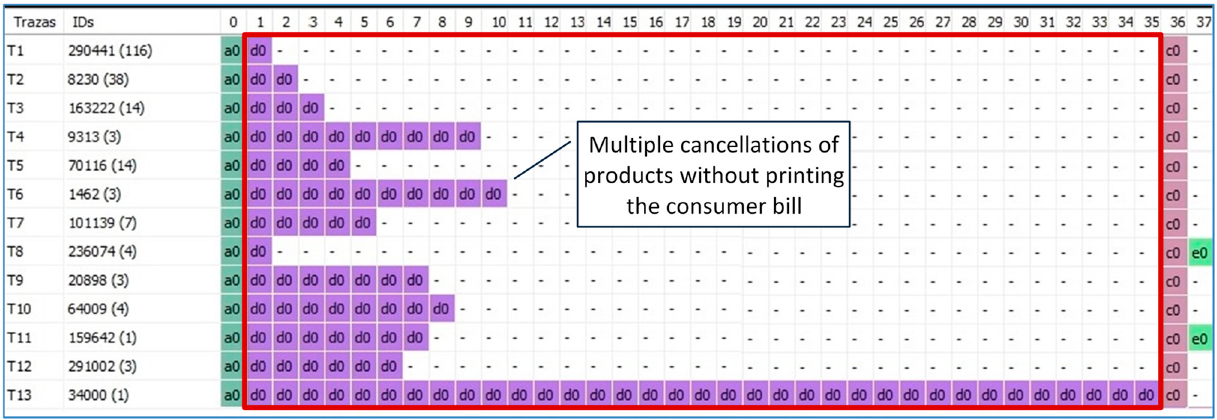
Figure 14. Sequences with product eliminations without the printing of the check.  Comparison of sequences with suppressed products depending on the means of pay ‐